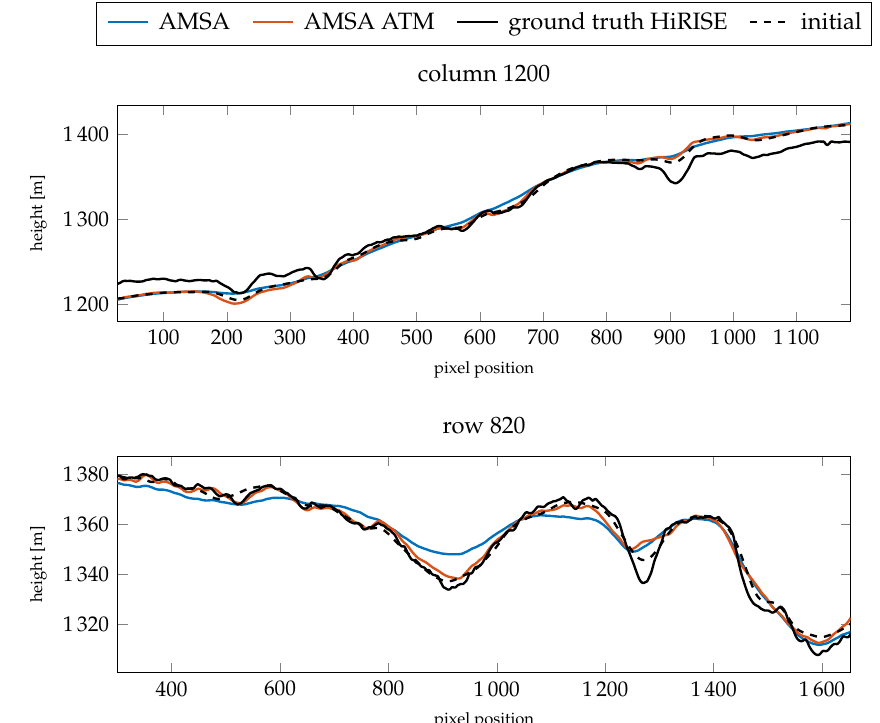
Figure 12. Resulting absolute heights compared for the two profiles investigated for image K13_058554_2232_XN_43N103W. The comparison is between the results for γ = 3 the fixed optical depth of τ = 0.61.